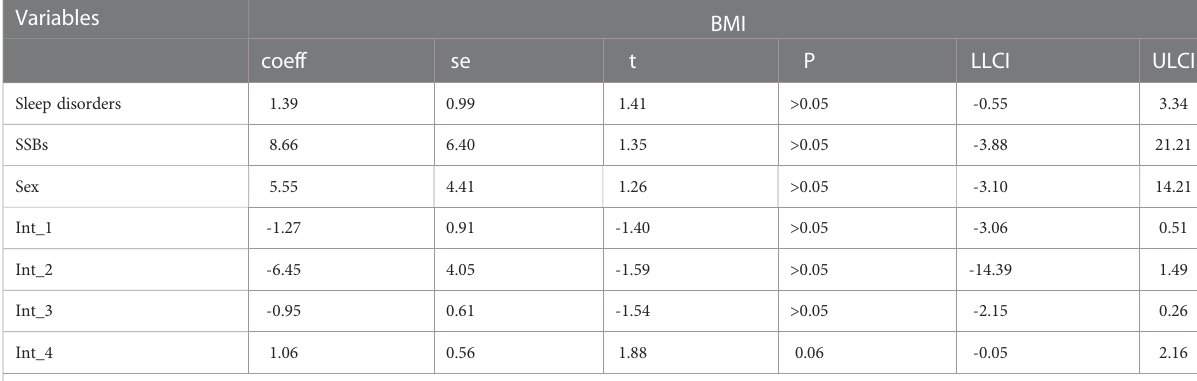
TABLE 4 The moderation analysis between SSBs, Sleep disorders, HbA1c and BMI.